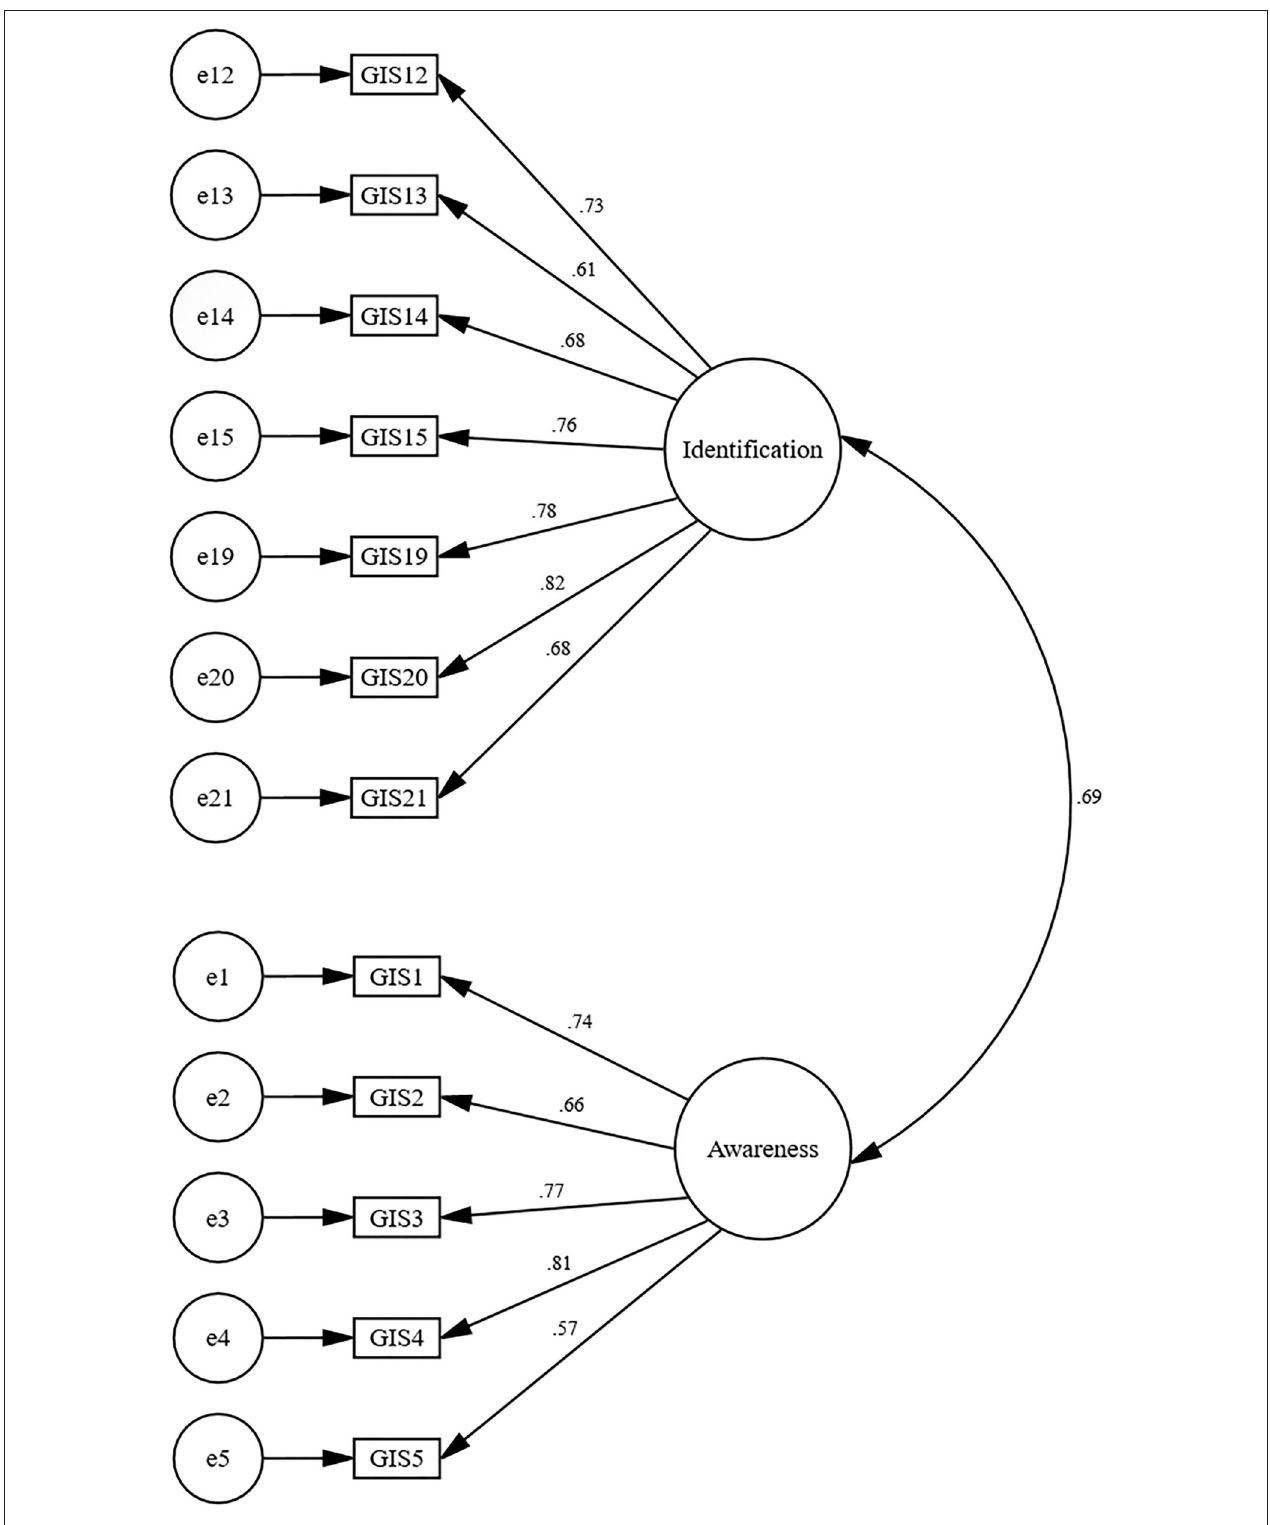
FIGURE 1 | Factor structure of the two-factor solution for the Generational Identity Scale (Standardised parameter) ( N